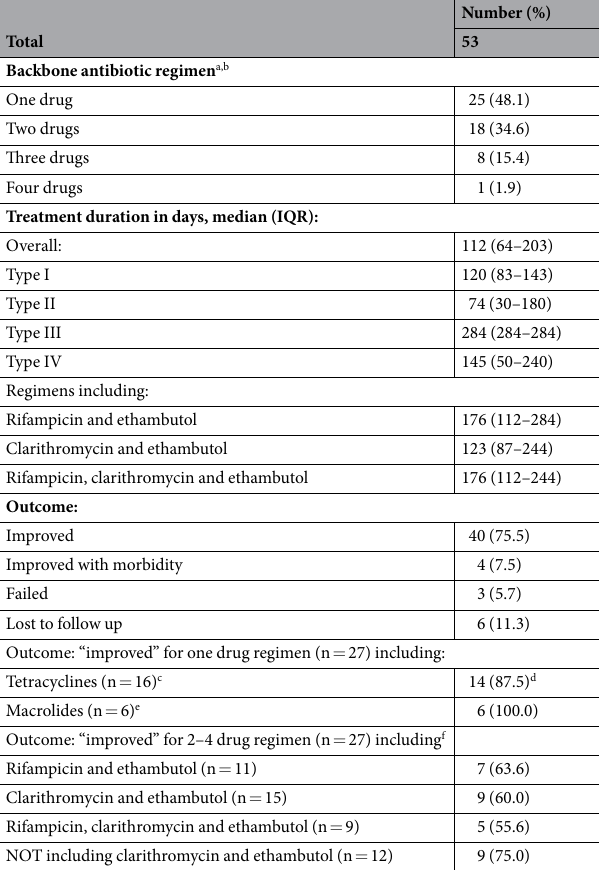
patients received immunosuppressive therapy. The results of this study revealed that 24 (45%) of the patients received a one-drug regimen. All of these patients had superficial cutaneous infection (type I: 80%, type II: 20%). Reported outcome was good; 88% of these patients were classified as improved and only one patient was classified as treatment failure at last contact. The remaining two patients in the group treated with a one-drug regimen were lost to follow-up. Infections with M. marinum are rare, consequently there have not been any trials comparing treatment regi- mens and the optimal combination of antibiotics and treatment duration remains unknown. In Denmark there is no national guideline regarding treatment of M. marinum infections. But according to the guidelines of the American Thoracic Society and the Infectious Disease Society of America, a combination of clarithromycin and ethambutol, with the addition of rifampicin for deep structure infection is preferred, and a one drug regimen is dis- couraged 29 . However, earlier studies have described a successful outcome with a single drug regimen for superficial cutaneous infection 8,10,15 . One-hundred percent of the patients treated with a 3 or 4 drug backbone regime received